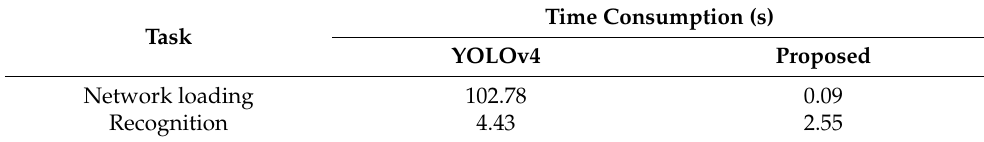
Table 3. Comparisons of time